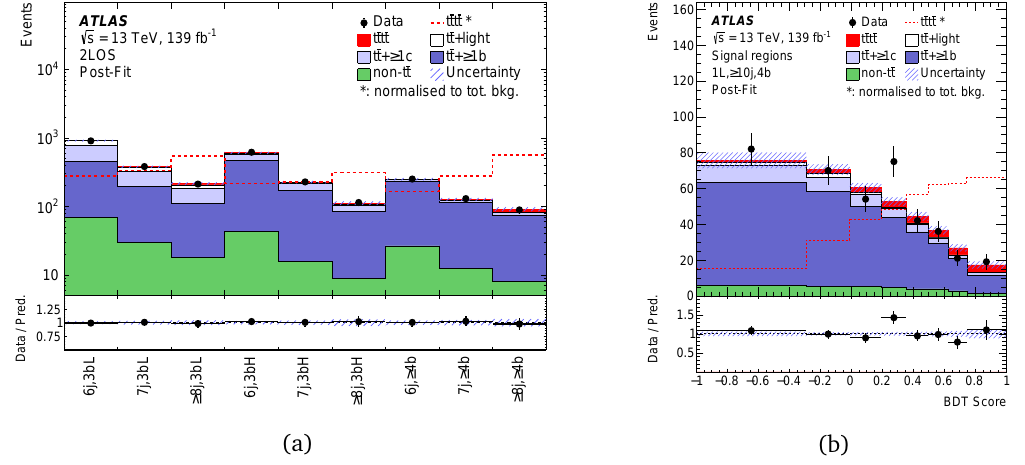
Figure 1: Post-fit agreement between data and simulation in various regions: (a) Yields for each SR and CR in 2LOS channel; (b) BDT distribution in (1L,10j,4b) SR. Shaded bands represent both statistical and systematic uncertainties [ 7 ]